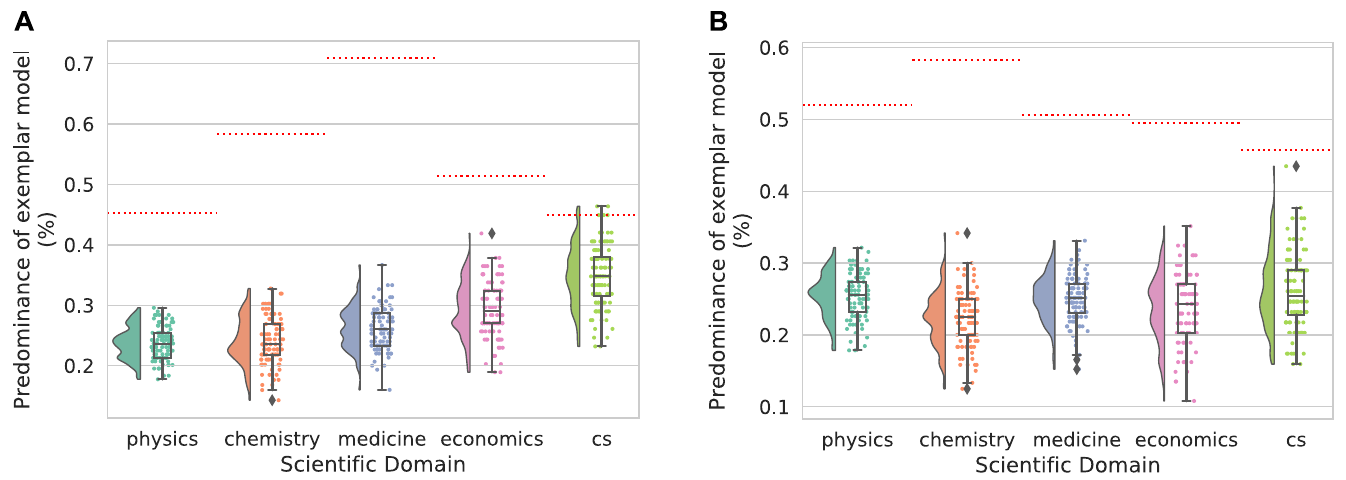
Fig 4. Summary of results from the time-shuffled analysis. (A) Comparison of the predominance of the exemplar model (model winning percentage indicated by the red dotted line) against the same statistics recorded in the 100 iterations from the time-shuffled tests (winning percentages shown in the boxplot with an accompanying histogram and scattered raw data). (B) Similar information for the random-sampled scientists.